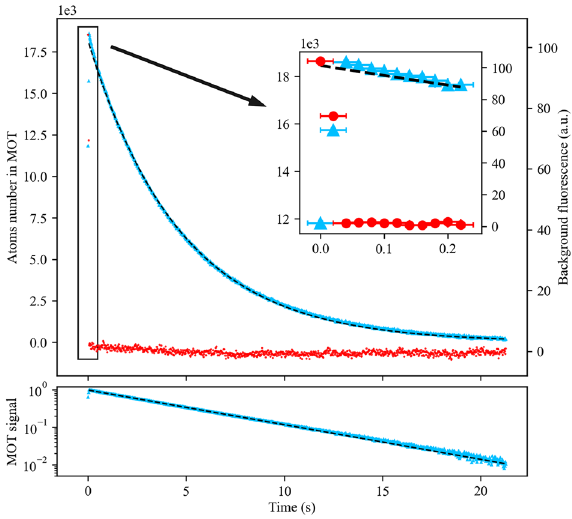
Figure 3. Experimental results of the short pulse sequence. Top panel: Temporal evolution of the cold atoms number (light blue triangles) and the strontium vapour (red circle), averaged over 78 runs of the experiment. The time origin corresponds to the ignition of the ablation laser. The decaying part of the MOT signal is fitted to an exponential function (black dashed line) to give a MOT lifetime of τ N = 4.7 ( 9 ) s. The uncertainty reflects one standard deviation of the lifetime measured over 1.5 h for the 78 runs of experiments. Inset: A zoom of the first 200 ms. The horizontal error bars reflect the temporal resolution of our measurement methods. Bottom panel: Normalized temporal evolution of atomic fluorescence signal in semi-log scale.